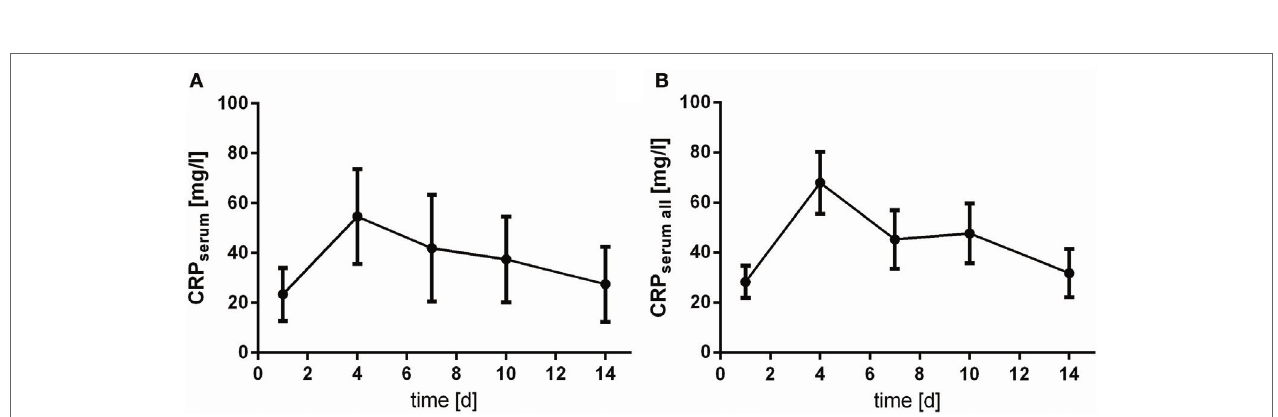
FigUre 5 | Time courses of C-reactive protein (CRP) in serum samples of the patients with cerebrospinal fluid samples [ (a) ; CRPserum] and all serum samples available [ (B) ; CRPserum all] and their 95% confidence interval are displayed. Differences between nadir and peak values assessed via Wilcoxon Rank Test: CRP: day 1 vs. day 4: p < 0.0001.